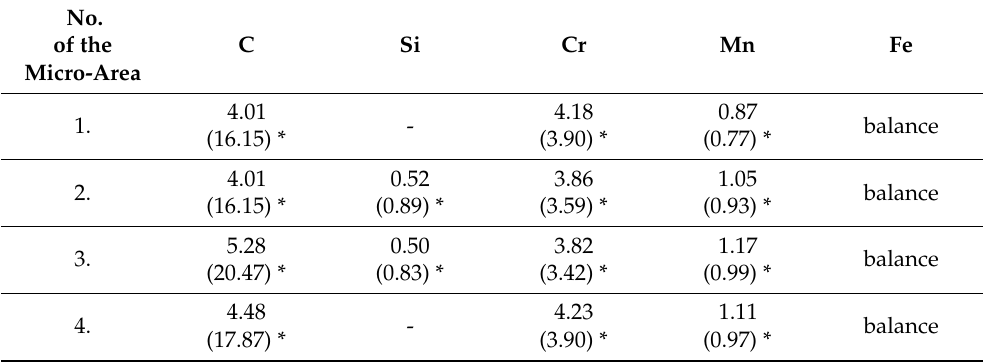
Table 1. The result of the micro analysis of the chemical composition from points 1–4. The compact- ness of the elements % by weight.